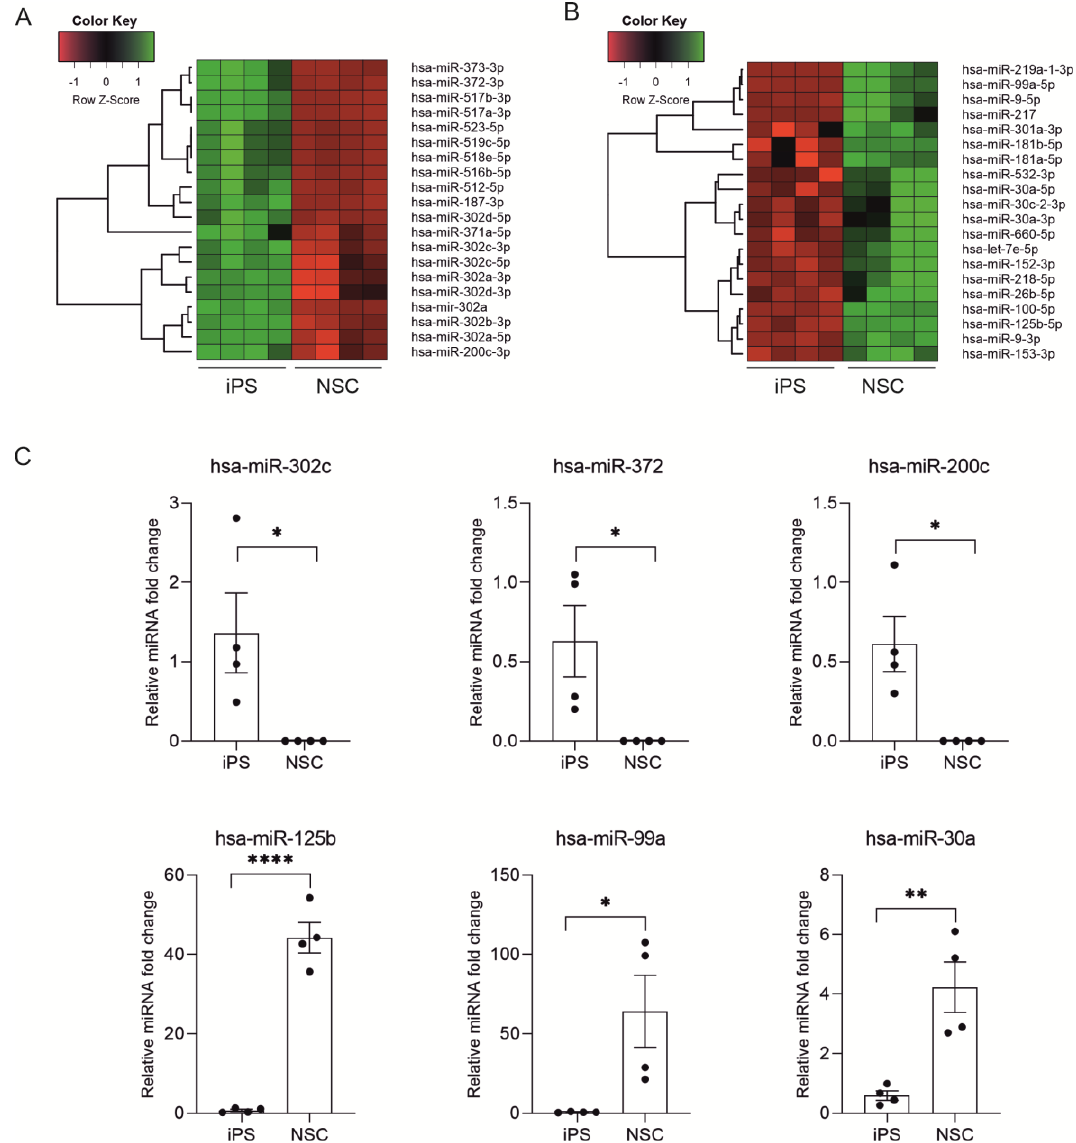
Figure 3. Real-time qPCR validation of microarray data. A) Microarray heat maps showing 20 highly downregulated ( A ) and upregulated ( B ) miRNAs in NSC cells. ( B ) Validation of 3 highly downregulated and 3 upregulated miRNAs in NSC by RT-qPCR. Graphs represents mean ± SEM. Each dot represents an individual cell line (mean from 3 experiments conducted on 1 cell line) ( C ). Statistical analysis was conducted using t-student test (* p < 0.05, ** p < 0.01, *** p < 0.001, **** p < 0.0001).